Question: What type of chart is this?
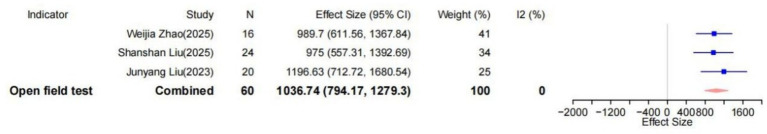
Answer: forest